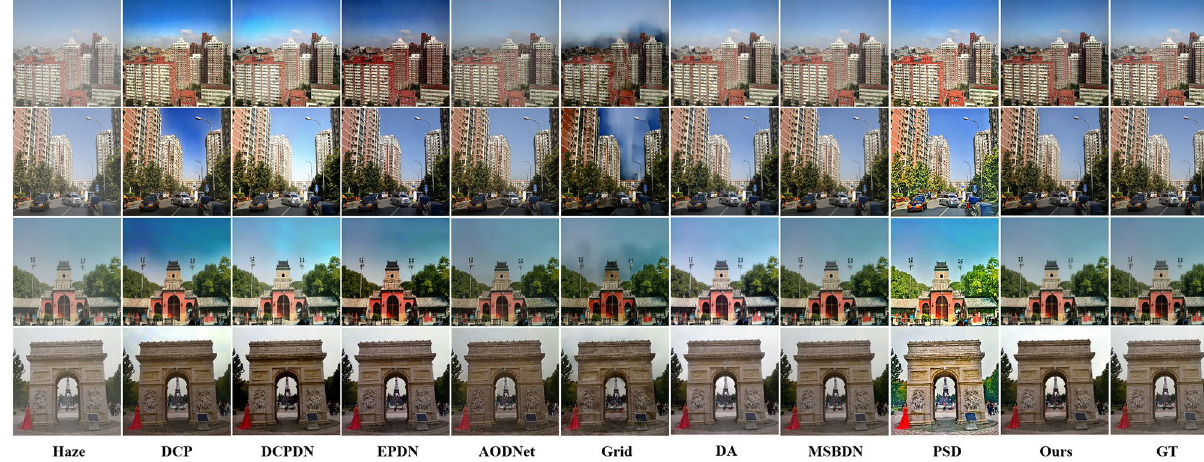
Figure 5. Results of comparison experiments on the SOTS outdoor datasets.